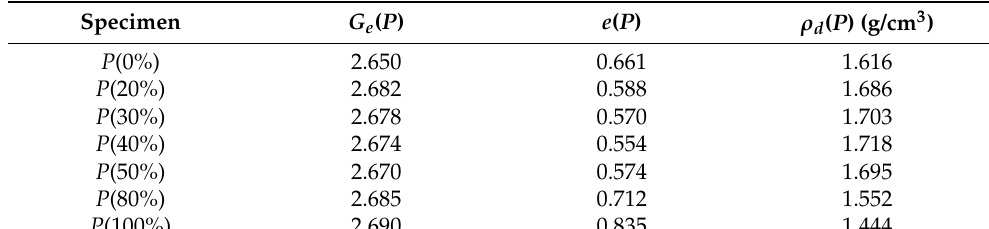
Table 2. Void ratio and dry density of gravel-mixed sample.